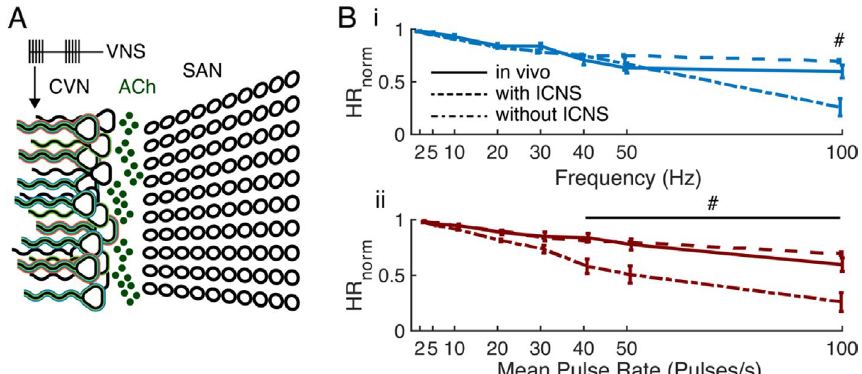
Fig. 10 Model perturbations cause the model response to deviate from in vivo data. A Diagram of the computational model of the connection of the cervical vagus nerve (CVN) to the sinoatrial node (SAN) of the heart without the intrinsic cardiac nervous system (ICNS) (Fig. 7A). Stimulation pulses (VNS) cause release of acetylcholine (ACh) to the SAN cells. B Normalized heart rate (HR norm ) response to VNS for in vivo data at bradycardia threshold (solid line), original model with ICNS (dashed line), and model with no ICNS (dot-dashed line) for constant frequency stimulation (i) and burst patterns with intra-burst frequency of 100 Hz (ii). Data presented as mean measured HR norm exceeded one standard deviation of in vivo data, n computational